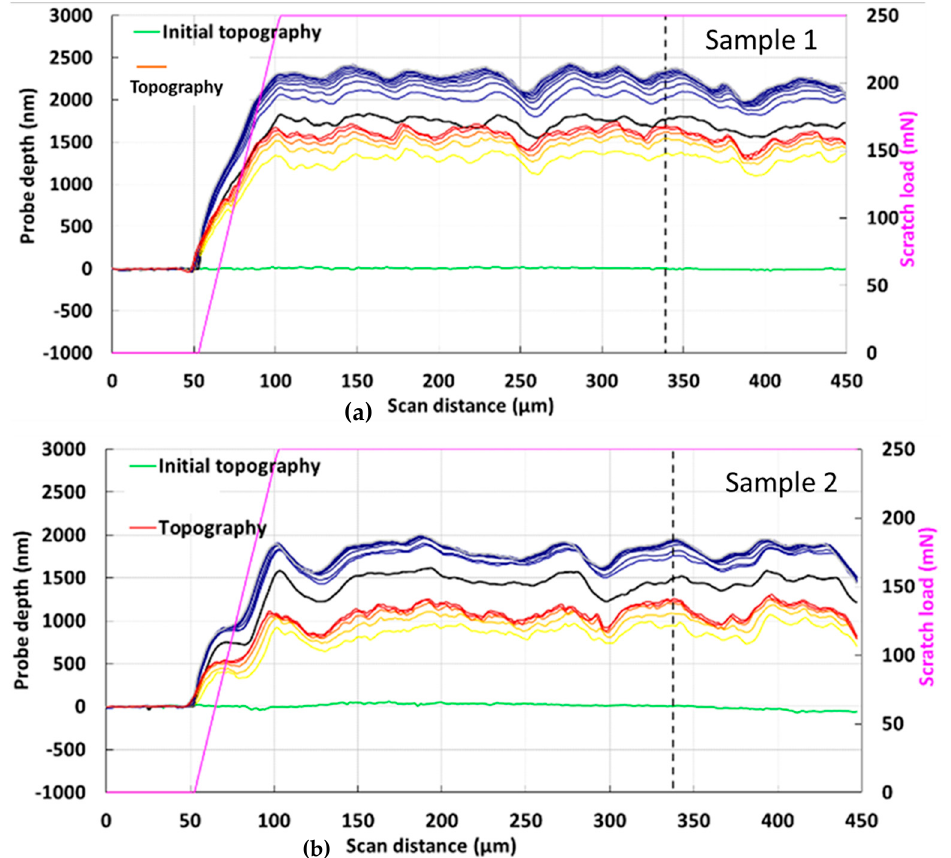
Figure 11. ( a , b ) Wear response of samples 1 and 2 at a 250 mN load with an indent radius of 10 μ m; shows probe depth and on-load depth.